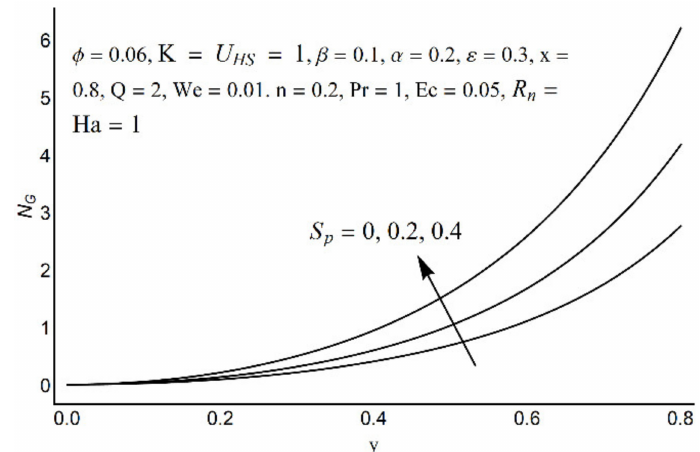
Figure 16. Entropy generation number for different values of S p .